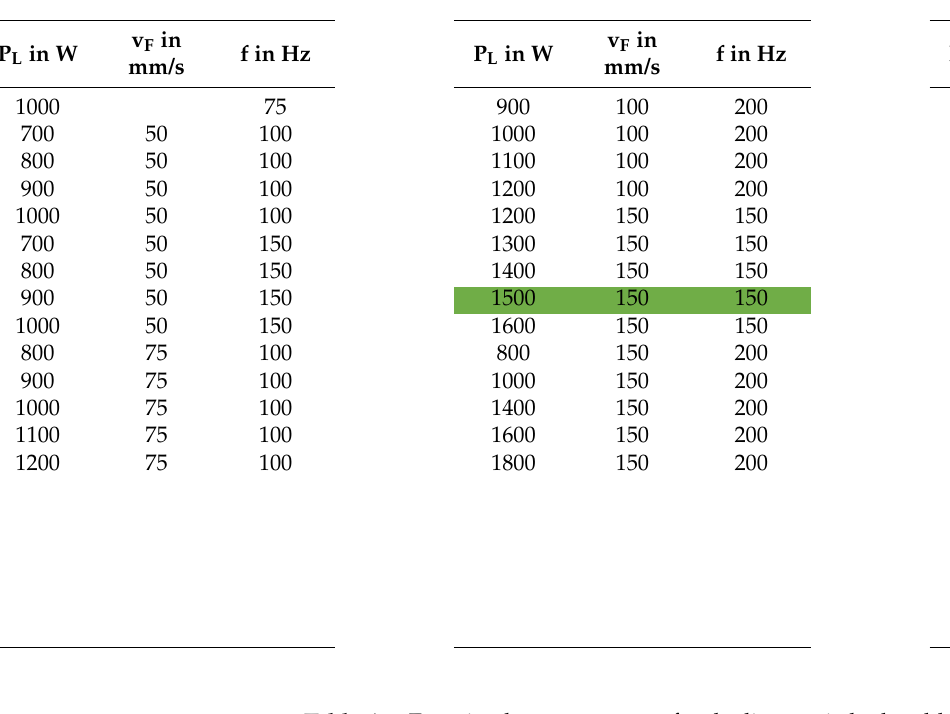
Table A2. Examined parameter sets for the linear stitched weld; reference parameter sets marked in